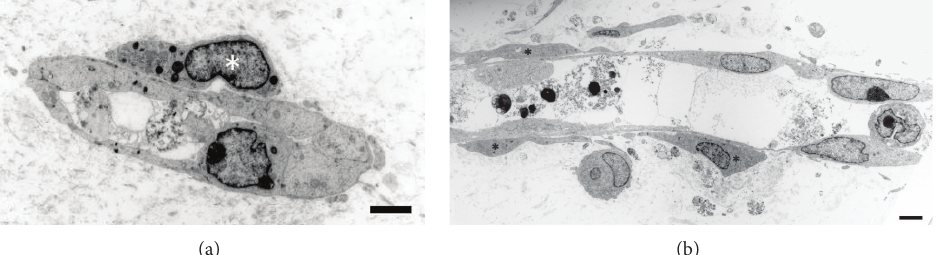
Figure 4: Transmission electron microscopy. (a) Electron microphotograph of a newly formed capillary tube from the mouse aortic explant in the collagen gel. A cross-section shows a capillary tube with a lumen that contains cell debris. Pericyte-like cells ( ∗ ) surround the tube. The edges of the cells are in contact with each other. Scale bar = 2 𝜇 m. (b) Electron microphotograph of a longitudinal section of a capillary tube. Pericyte-like cells ( ∗ ) surround the tube. Scale bar = 2 𝜇 m.